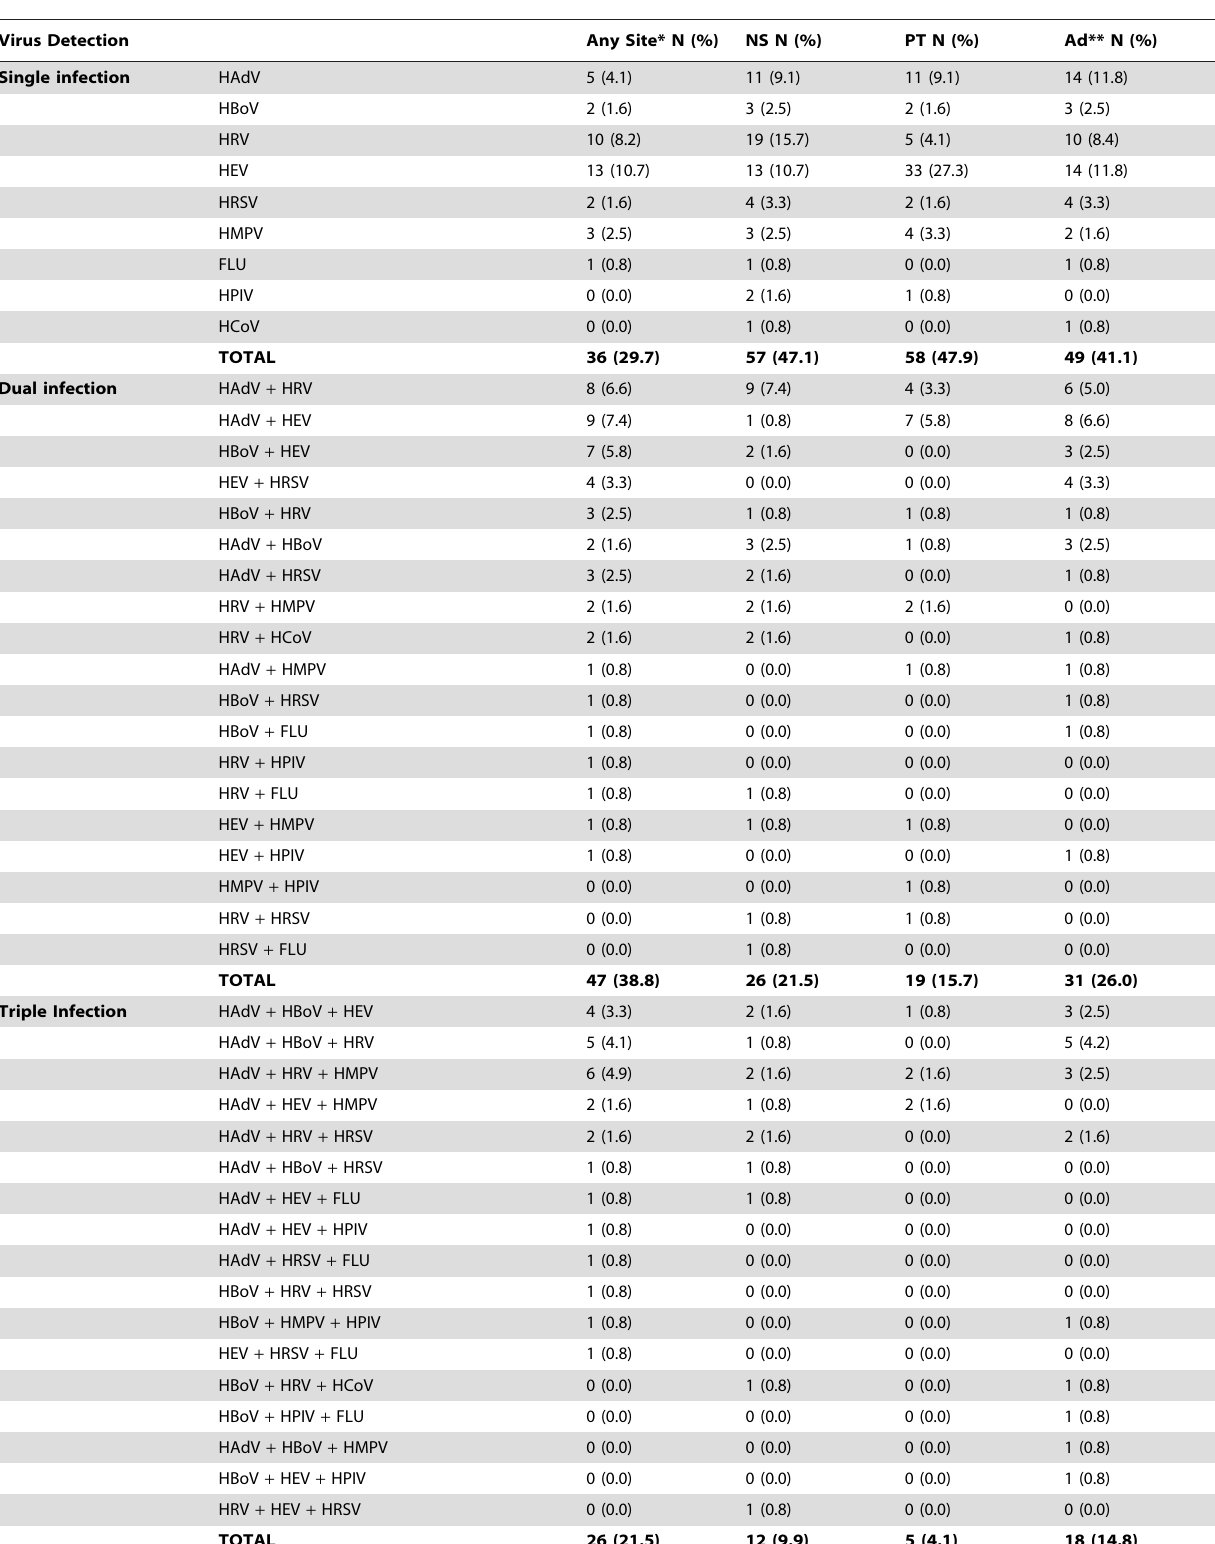
Table 3. Frequencies of specific viruses and viral associations at different sample sites in 121 patients with chronic adenotonsillar